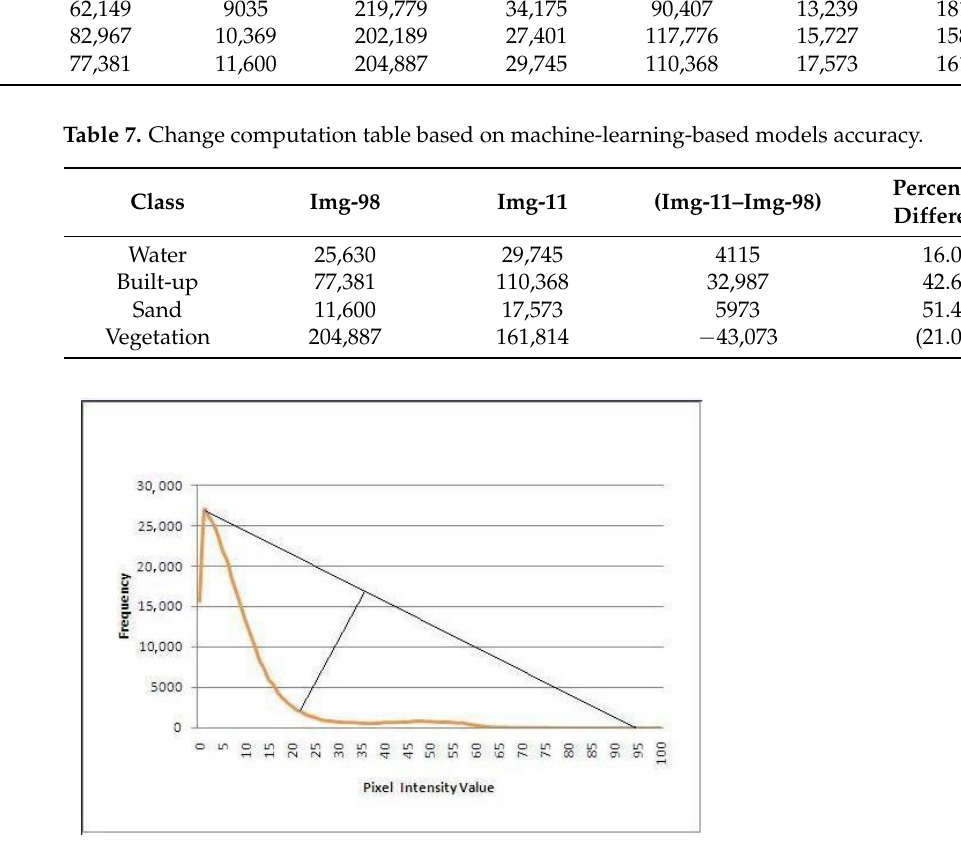
Figure 8. Result with decision tree classifier on the images of both dates. The x -axis of the histogram represents the intensity value of the pixels, and the y -axis represents the number of pixels corresponding to the intensity value. A straight line was drawn between the peak and the lowest point in the curve. The perpendicular distance between the point and the line was calculated from each point in the curve. The point with the maximum distance from the line was selected, and the corresponding x coordinate was chosen as the threshold to classify the change image matrix into two classes (change and no-change). The intensity values which are greater than the computed threshold values are classified as change; otherwise, they are no-change. The false color image of the outcome